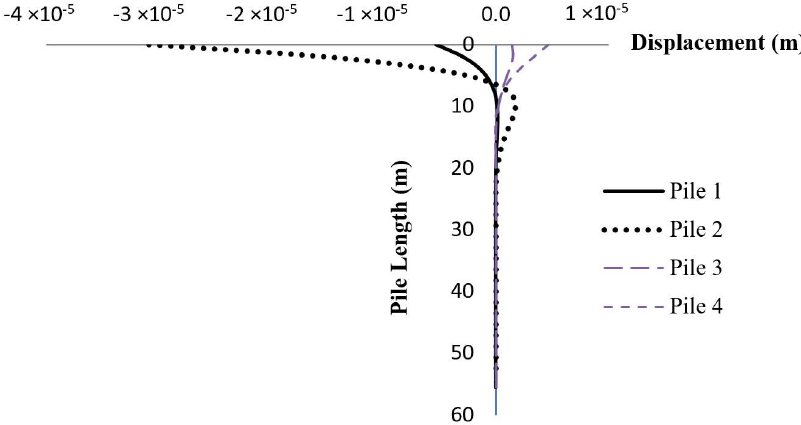
Figure 19. The maximum distribution of displacement along the pile length in the transverse direction (y).